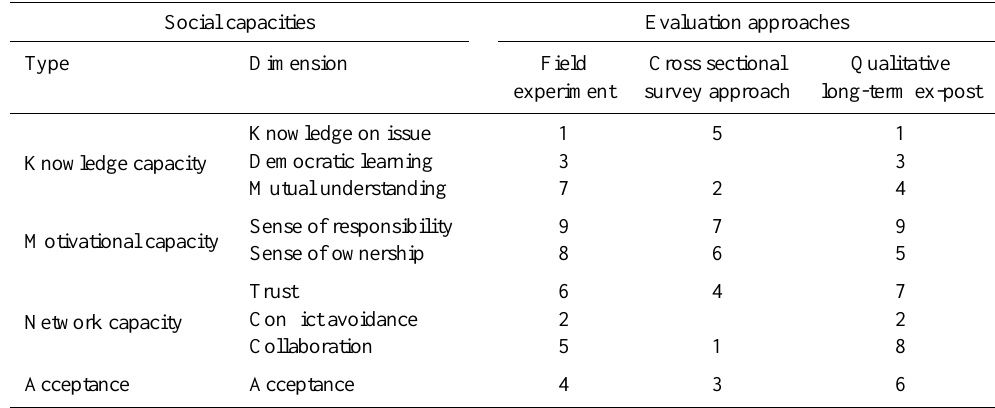
Table 3. Ranking of the effects of the stakeholder involvement processes on the different social capacity dimensions according to the three evaluation